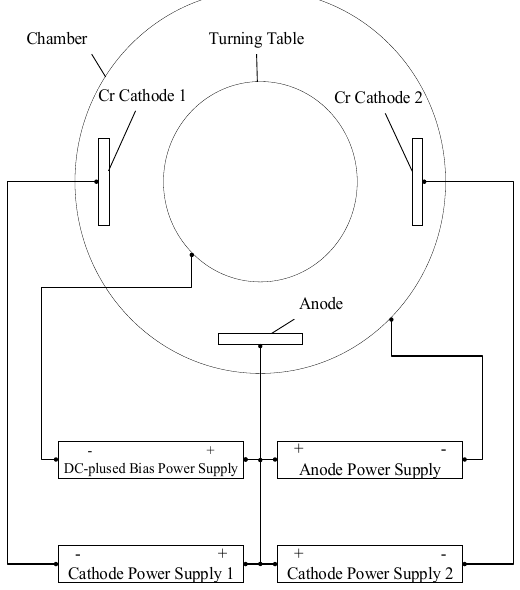
Figure 1. Schematic diagram of magnetron sputter equipment.